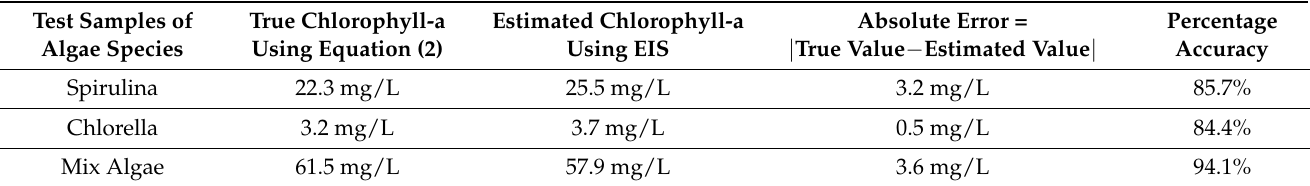
Table 1. Chlorophyll-a for the new test samples of algae species and validation of the EIS models. Test Samples of Algae